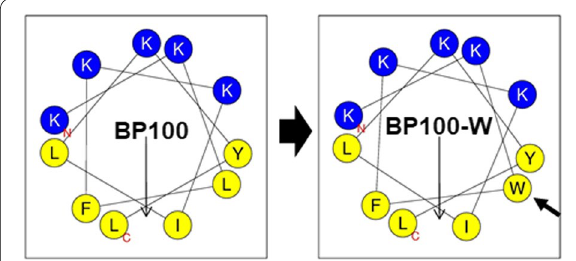
Fig. 1 Helical wheel projection diagrams of BP100 and BP100-W. Positively charged residues (polar) are represented by blue circles and hydrophobic (nonpolar) residues are represented by yellow